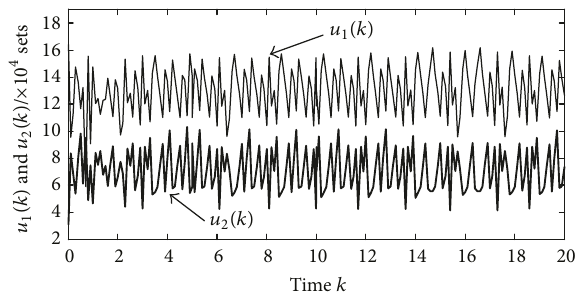
Figure 5: Evolution processes of production and ordering quantity under the robust 𝐻 ∞ control strategy.